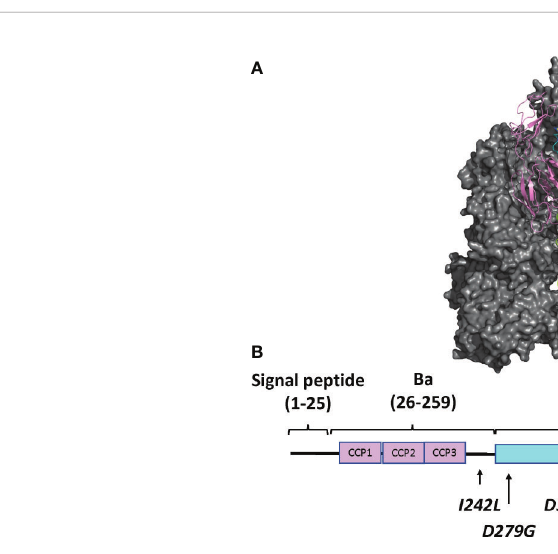
FIGURE 1 | The molecular structure of factor B and the location of mutations described in this study. (A) Location of the four mutated residues (D371G, E601K, I242L and D279G), visualized on the structure of the C3 pro-convertase C3bB depicted in grey (PDB ID 2XWJ) (18) using PyMol. The Metal Ion Dependent Adhesion Site (MIDAS) on C3b is depicted by a star. The colors of the domains correspond to the domains depicted in (B) . (B) The linear structure of factor B divided into the signal peptide/leader, Ba and Bb fragments with a linker sequence in between. The amino acid numbers are given in parentheses. The protein is composed of a complement control protein (CCP) domain with three CCPs, followed by the linker, the von Willebrand factor type A domain (VWA) and the serine protease (SP) domain. The location of mutations studied herein is